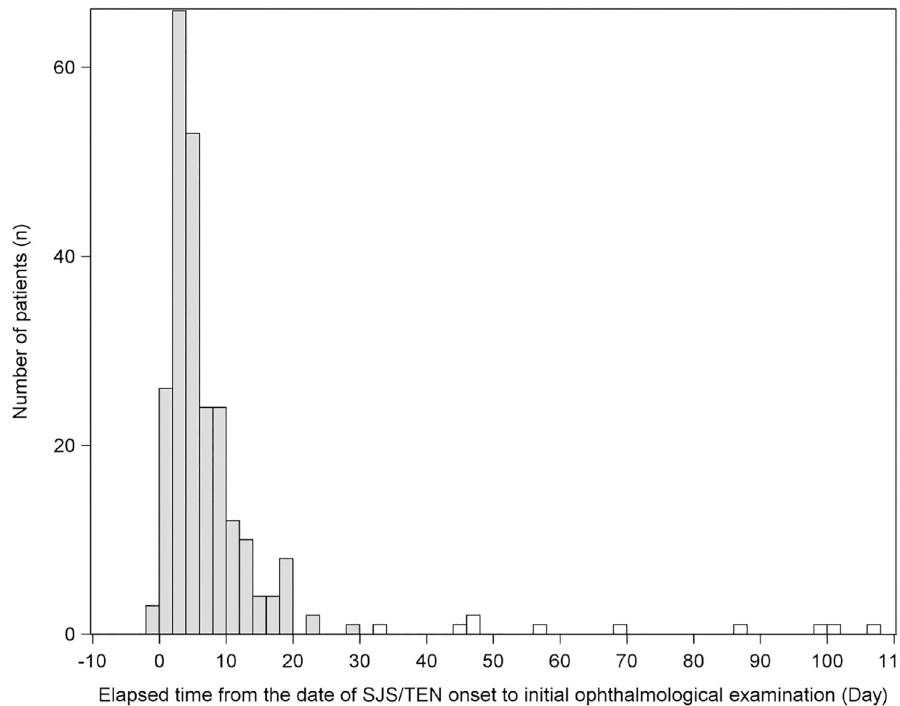
Fig 3. Elapsed time from the date of SJS/TEN onset to initial ophthalmological examination. The grey bars indicate the patients who underwent ophthalmological examination within 30 days post disease onset.